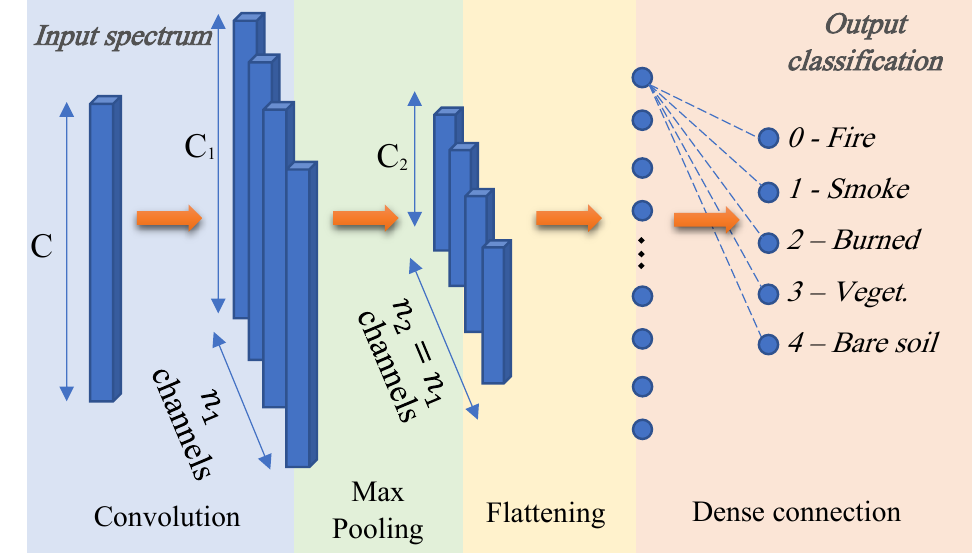
Figure 4. Multi-class classification CNN model [18].